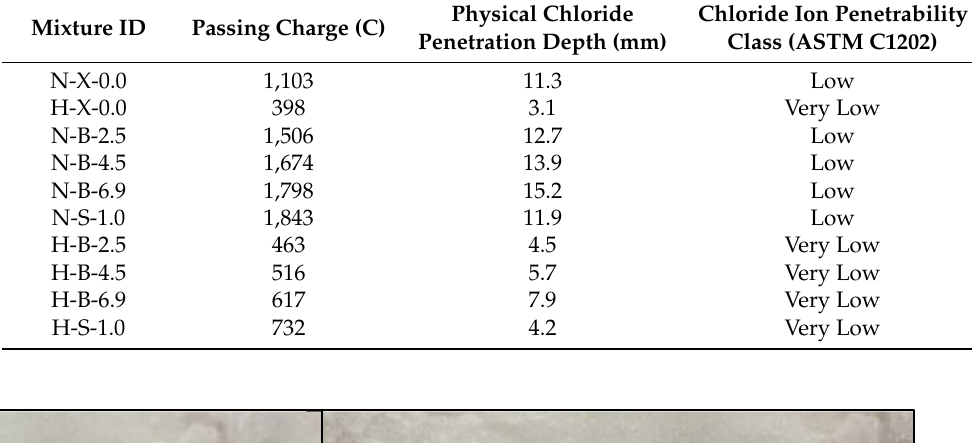
Table 9. Average RCPT results.